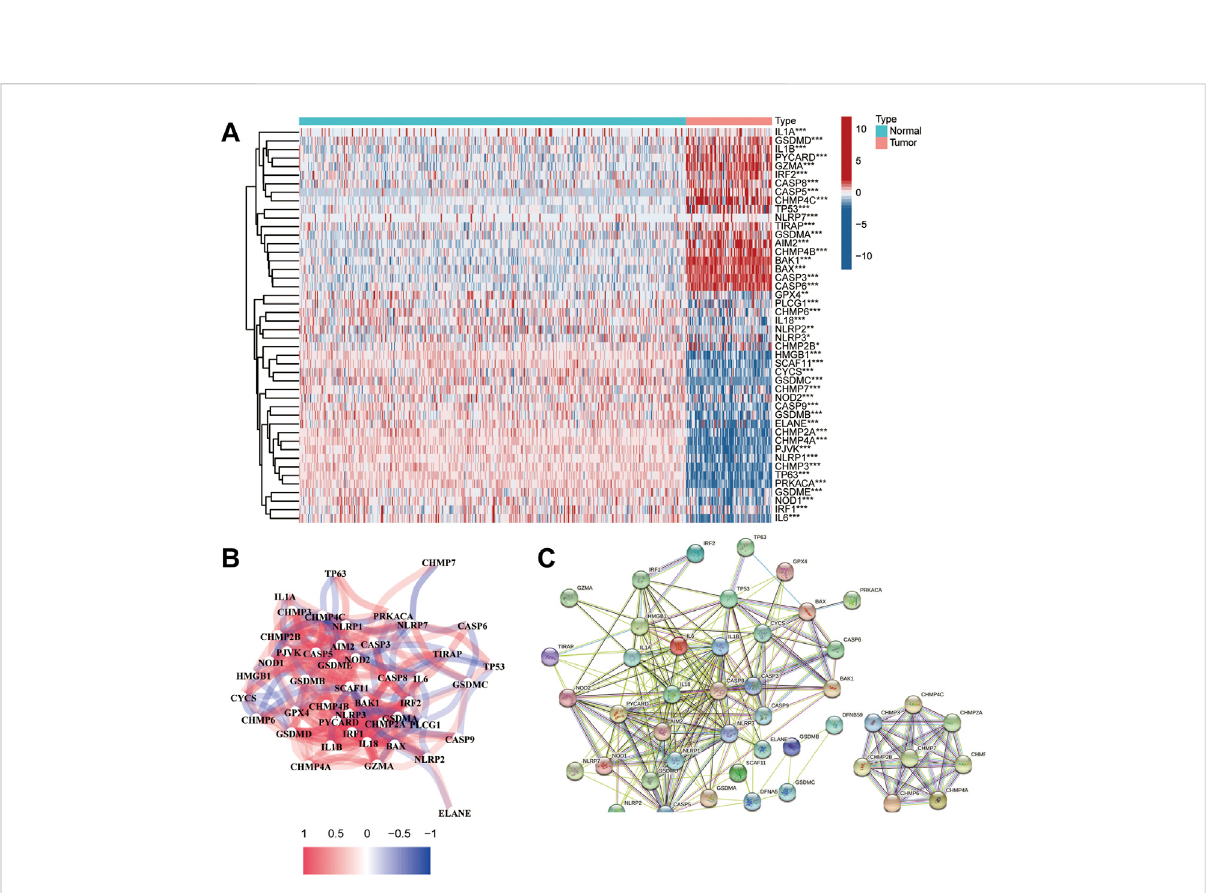
FIGURE 8 Identi fi cation of DEGs between healthy and tumor tissues. (A) Heatmap of the PRGs expressed in normal and tumor tissues; (B) The network of the PRGs showing interactions among the genes; (C) PPI network of the PRGs.